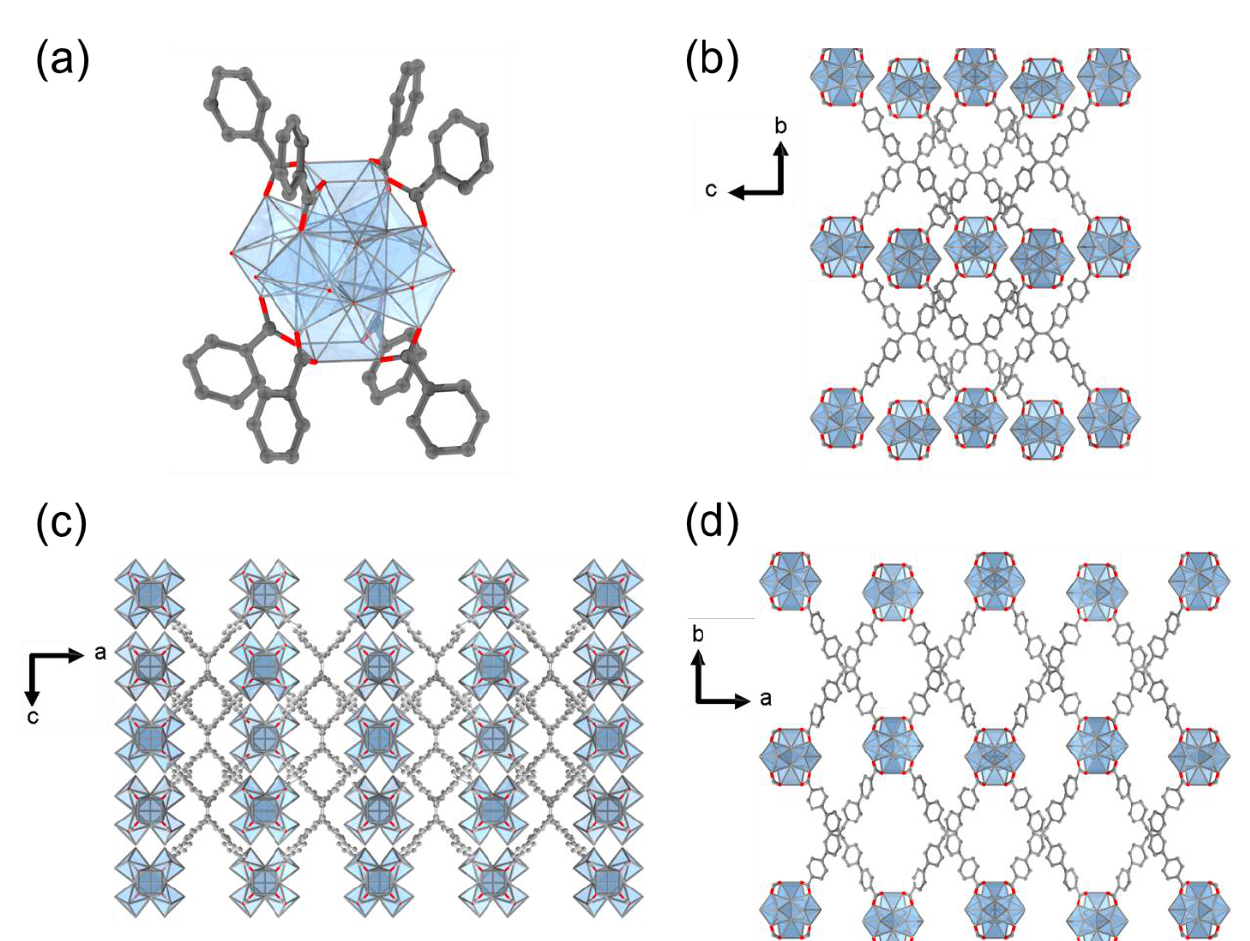
Figure 1. Crystal structure of 1 . ( a ) 8-connected zirconium SBU, ( b ) two-fold interpenetrated nets along the crystallographic a -axis, ( c ) b -axis, and ( d ) c -axis.